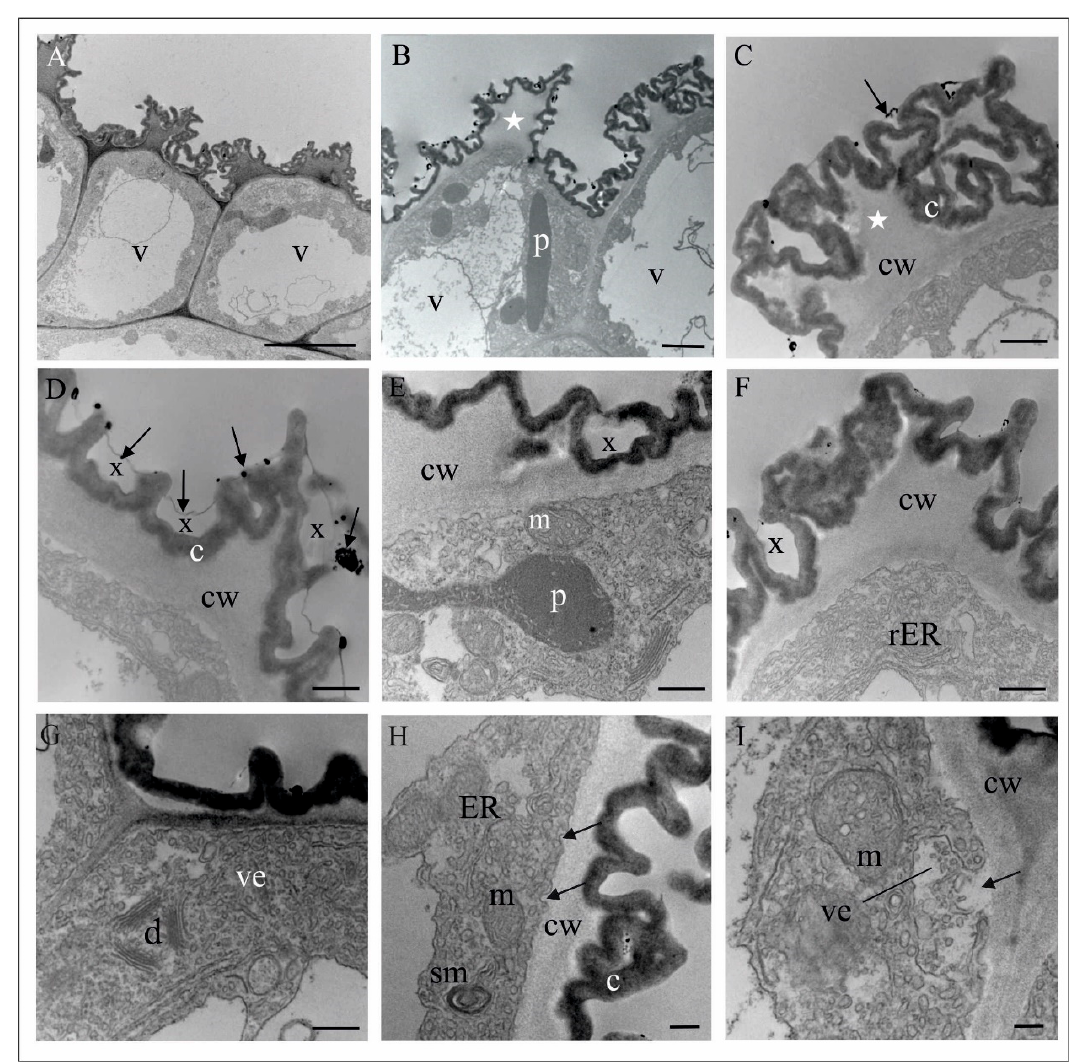
Figure 3. Ultrastructure of the inner surface of the M. monophyllos labellum: cells with the strongly undulated surface (shown in SEM: Figure 2D). ( A – C ) Strongly vacuolated epidermal cells; the outer wall with irregular outgrowths (stars), covered with folded cuticle; ( C – F ) The numerous crypts of the folded cuticle with homogeneous material (x) secreted from the cells with an osmophilic sediments and granules on the surface (arrows); ( A – I ) the dense parietal cytoplasm containing plastids with plastoglobuli, mitochondria, dictyosomes, and extended membrane system (profiles of rough and smooth reticulum, numerous vesicles and myelin-like structures). Single vesicles fusing with plasma membranes near the cell wall ( H , arrows); whole vesicles are released beyond the protoplast (( I ), arrow)). Scale bars: 2 µ m, 2 µ m, 1 µ m, 500, 500, 500, 500, 500, 500, 500, 200, 200 nm. c